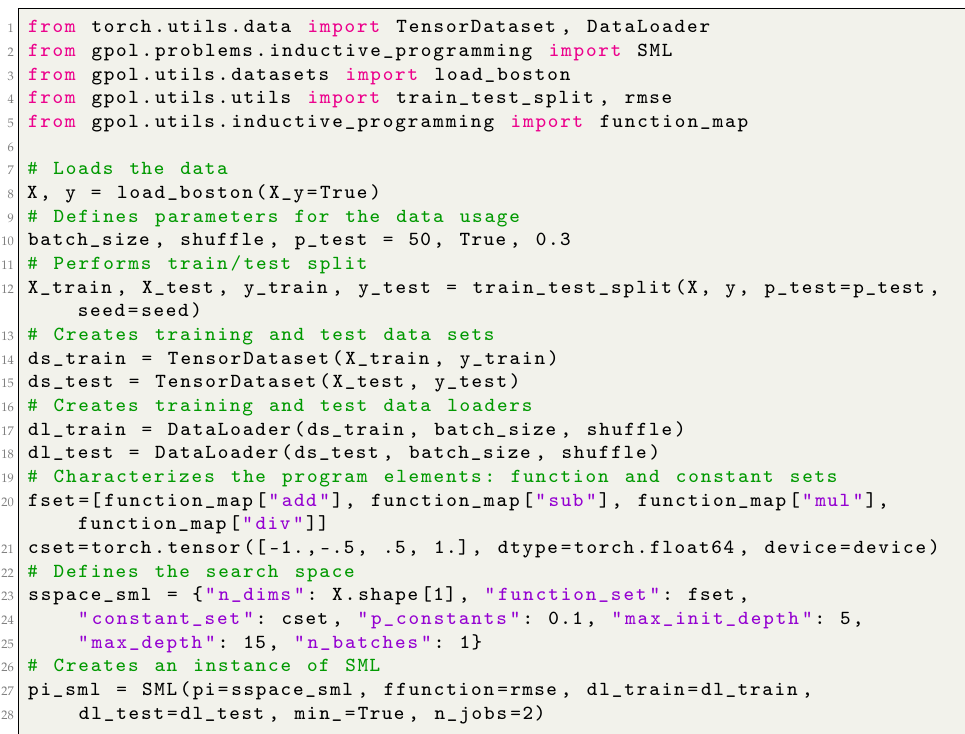
Figure A4. A demonstration of how to create an instance of SML